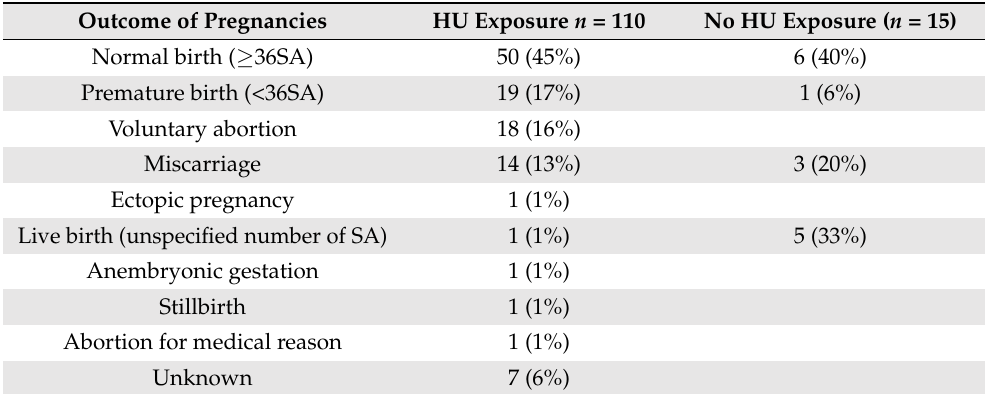
Table 4. Outcomes of pregnancies in ESCORT-HU SCD women following HU exposure or not. Outcome of